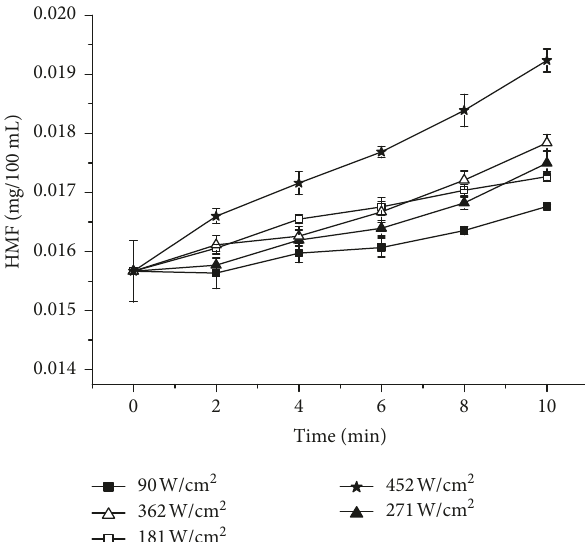
Figure 6: Effects of ultrasound processing on the activity of SOD in bayberry juice.